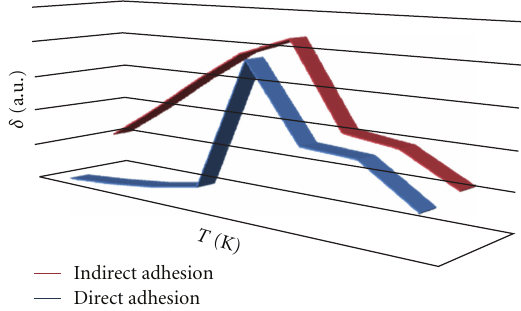
Figure 1: Indirect adhesion wear of cutting tools (arbitrary units) as a function of cutting temperatures.